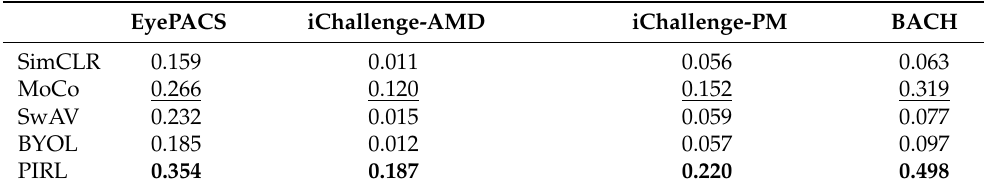
Table A1. Rotational invariance evaluated on the retinal fundus datasets, as well as Hue colour